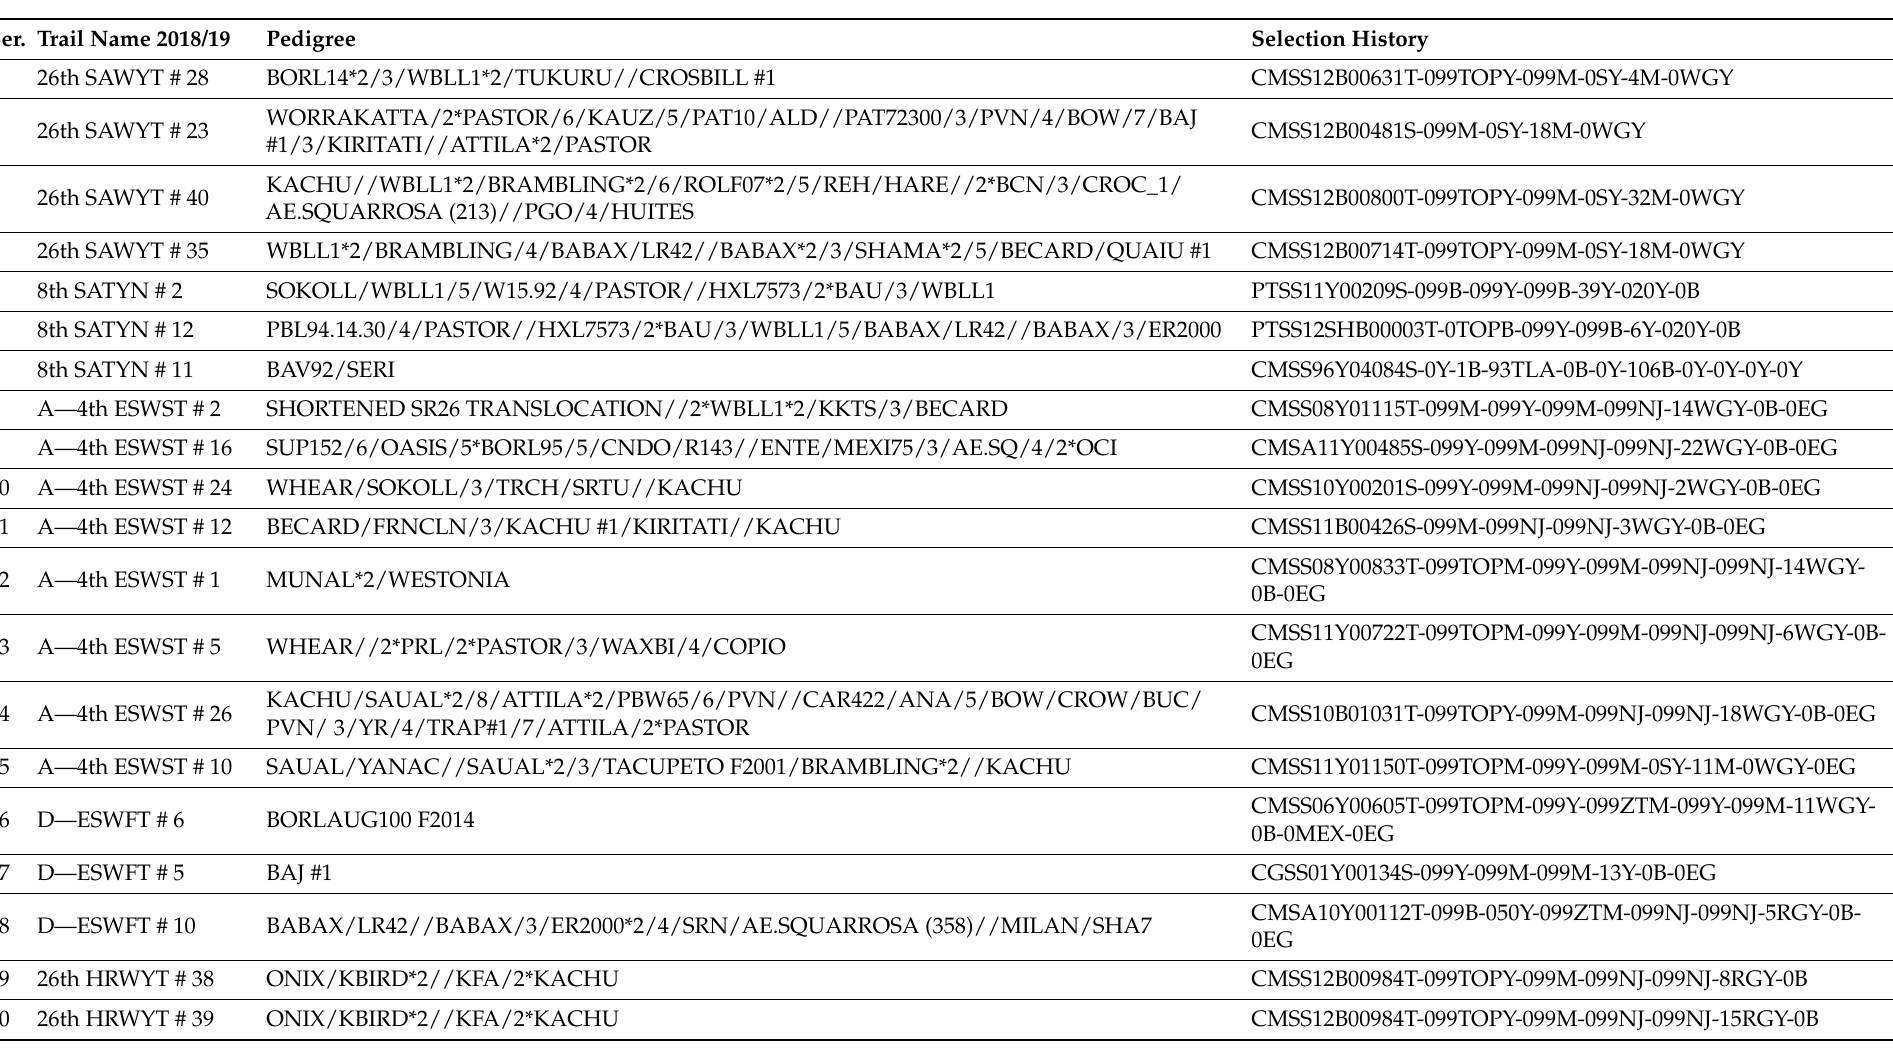
Table 1. Trial name, pedigree, selection history of selected forty genotypes to evaluation under control (tap water), and three salinity levels of diluted seawater in season